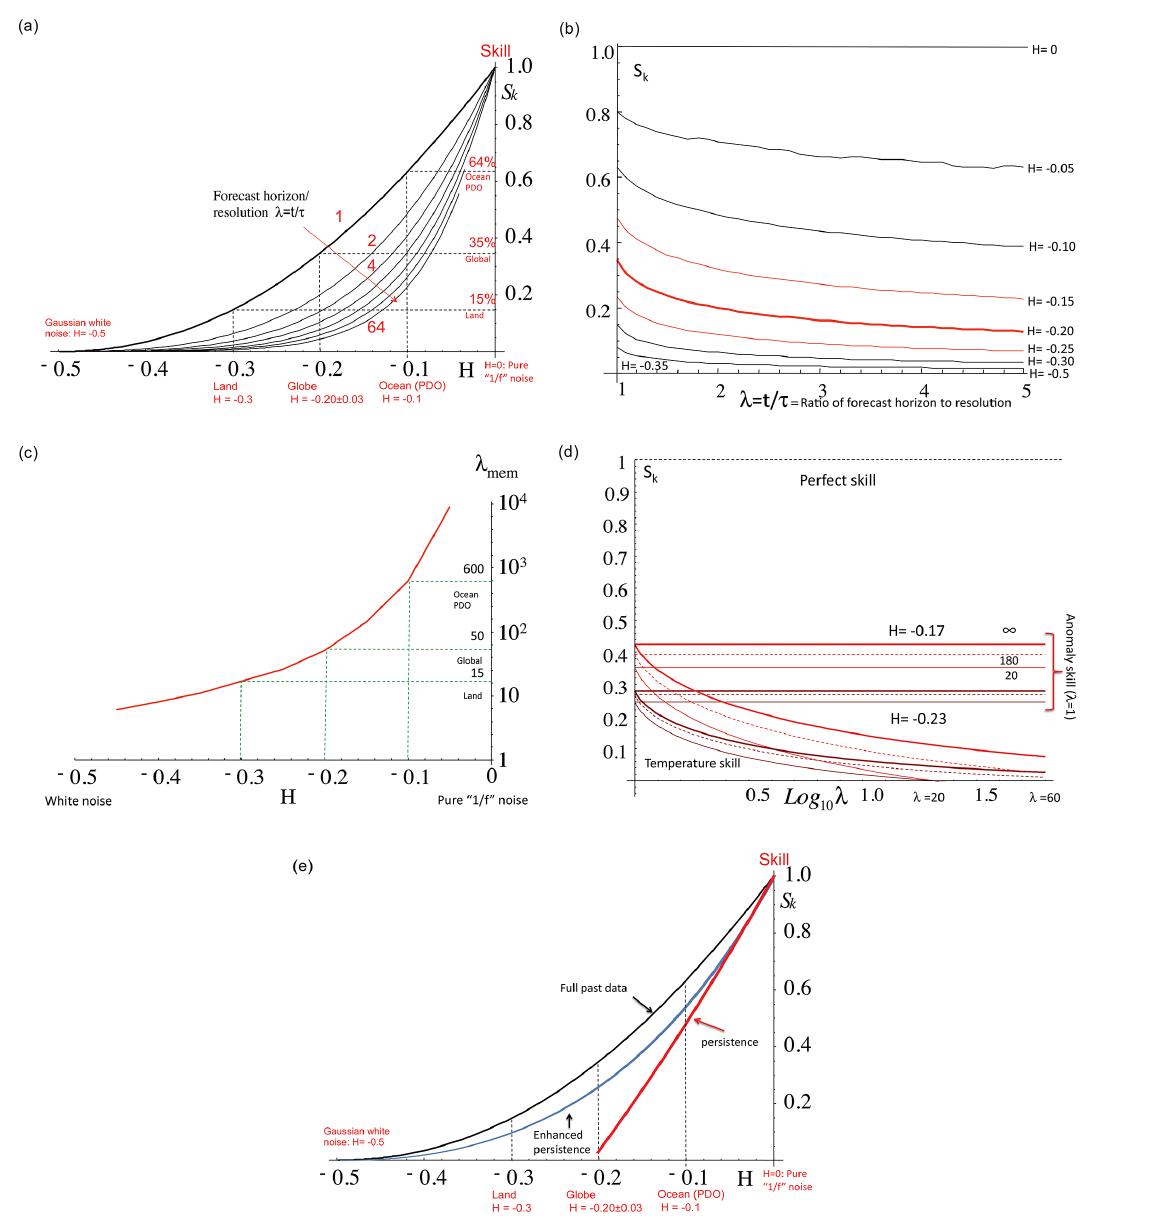
Figure 1. (a) Forecast skill for nondimensional forecast horizons λ = t/τ = 1, 2, 4, 8, ... 64 (left to right) as functions of H . For reference, the rough empirical values for land, ocean and the entire globe (the value used here; see below) are indicated by dashed vertical lines. The horizontal lines show the fraction of the variance explained (the skill, S k ; Eq. 46) in the case of a forecast of resolution τ data at a forecast horizon t = τ ( λ = 1; corresponding to forecasting the anomaly fluctuation one time unit ahead). (b) The theoretical skill with infinite memory for various ratios of nondimensional forecast horizons λ over the range 0 ≥ H ≥− 0.35 (top to bottom in steps of 0.05). The limiting value H =− 1 / 2 corresponds to Gaussian white noise with zero skill. The empirically relevant range for the whole earth ( H ≈− 0.20 ± 0.03) is in red; the thick line represents the best estimated parameter ( H =− 0.20). (c) This illustrates the potentially huge memory in the climate system (especially the ocean). It gives the λ mem value such that S k,λ (1) /S k, ∞ (1) = 0.9. When H =− 1 / 2, there is no memory and λ mem mem is not defined; it diverges when H → 0. (d) The theoretical skills for hindcasts with infinite (Eq. 46) and finite memory (Eq. 49) for the empirically relevant parameter range ( H =− 0.23, brown, bottom; H =− 0.17, red, top). The flat (constant skill) at the top are the curves for the anomaly forecasts (i.e. with forecast horizon, t is equal to the resolution τ so that λ = 1); the bottom curves are for constant resolution τ with forecast horizon. In each case a triplet of curves is shown corresponding to varying lengths of memories used in the forecast: infinite, 180 and 20 (the latter two corresponding to those used for the monthly and global forecasts analysed here). (e) The skill of λ = t/τ = 1 forecasts using the full memory (black, Eq. 46, from a ), the corresponding classical persistence forecast (red), S k = 1–4 (1–2 2 H ) and the corresponding “enhanced persistence” result (blue; for this λ = 1 case, this is the same as the AR(1) (autoregressive order 1) model forecast) with S k = (2 2 H + 1 − 1) 2 . With classical persistence the skill becomes negative for H < ≈− 0.2, so it is not shown over the whole